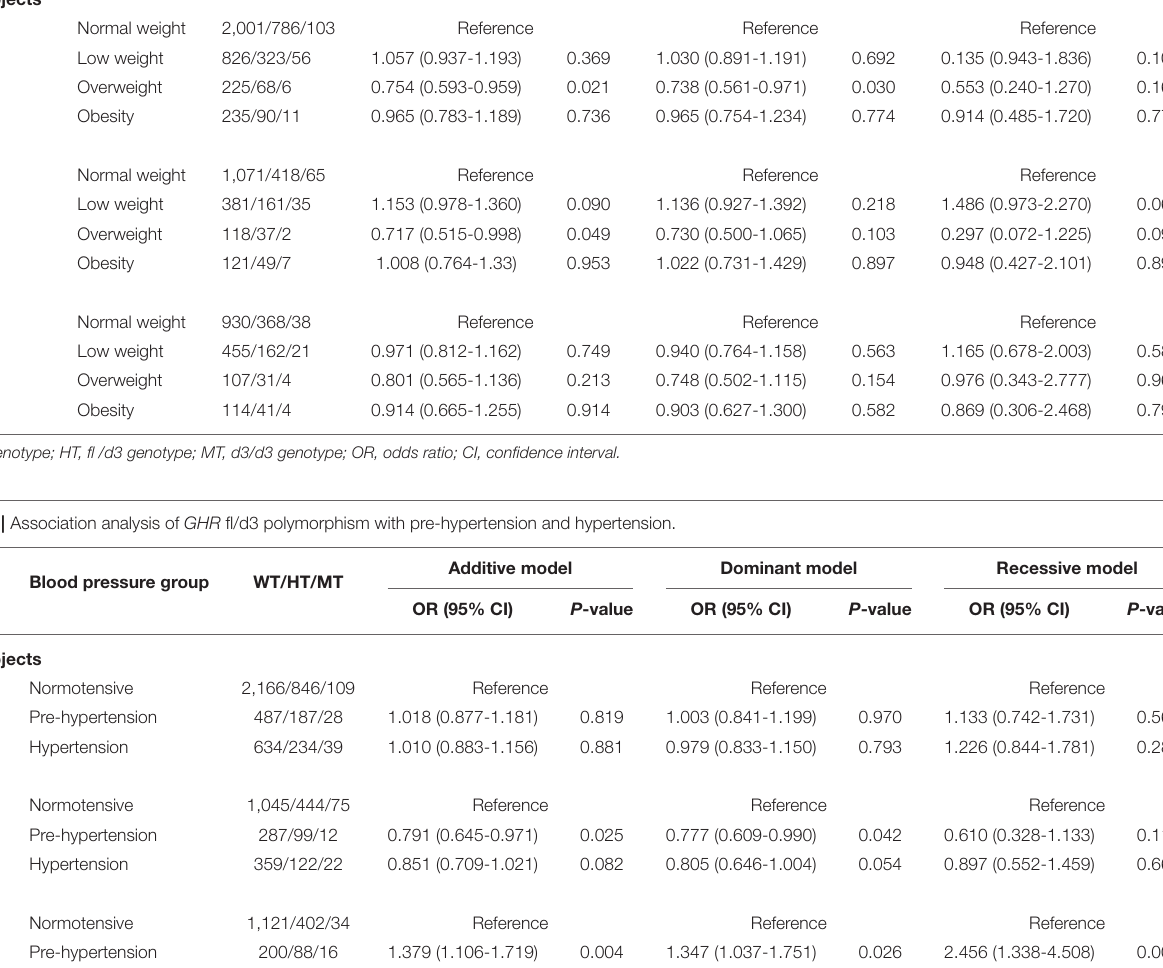
10- or 11-year groups ( Supplementary Figure 4 ). GHR d3 allele was associated with reduced odds of pre-hypertension and hypertension in Yixing boys (ORs [95% CIs] for the additive model and dominant model: 0.750 [0.585-0.962], P = 0.023; 0.757 [0.587-0.976], P = 0.031; Supplementary Table 3 ). Conversely, GHR d3 allele was associated with increased odds of pre-hypertension and hypertension in Yixing girls (ORs [95% CIs] for the additive model: 1.366 [1.055-1.770], P = 0.018; 1.273 [1.009- 1.606], P = 0.042). No significant associations were found between GHR fl/d3 polymorphism and hypertension in Suqian